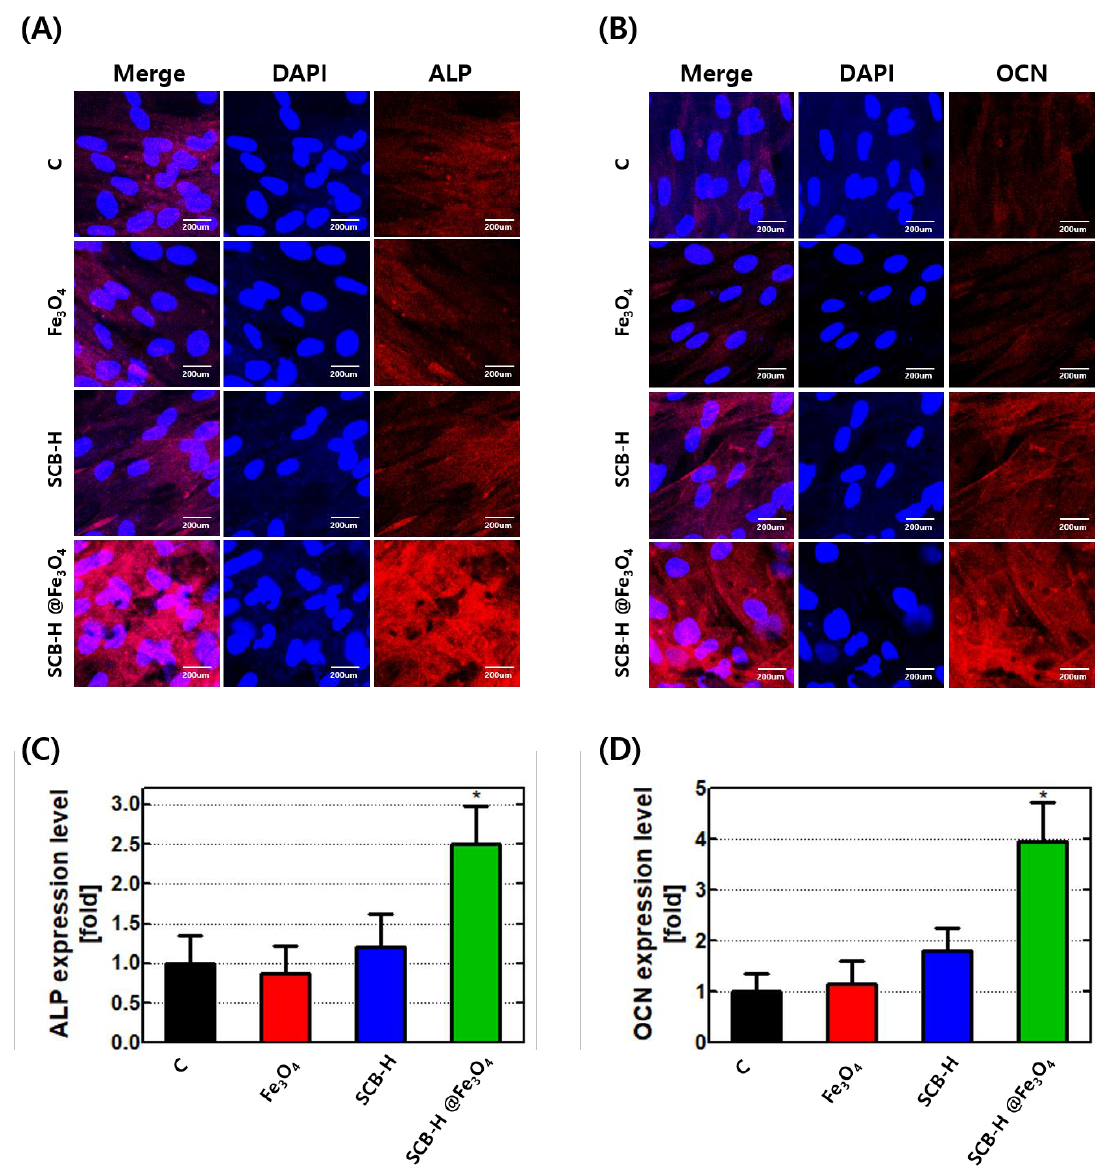
Figure 6. The protein levels of OCN and ALP. hADMSCs were differentiated to osteoblasts for 14 days in osteogenic induction media with or without nano-scaffolds. After differentiation, the protein levels of osteogenic markers ( A ) ALP and ( B ) OCN were analyzed by immunocytochemistry. All results were quantified using ImageJ Software ( C ) ALP and ( D ) OCN. All materials are treated with 100 µg/mL for every cell. C: vehicle.